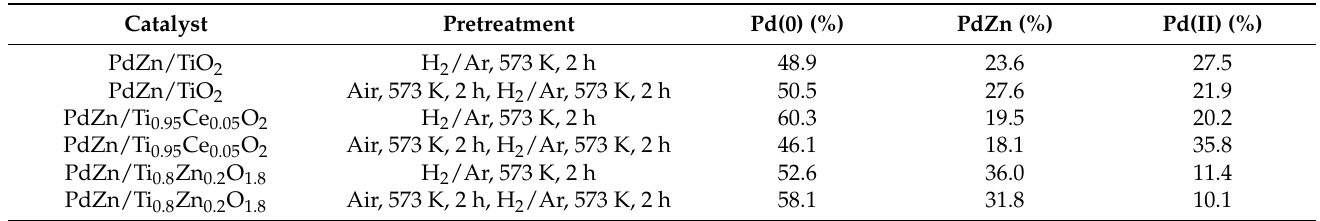
Table 5. XPS analysis of Pd 3d 5/2 PdZn/TiO 2 , PdZn/Ti 0.95 Ce 0.05 O 2 , and PdZn/Ti 0.8 Zn 0.2 O 1.8 after different